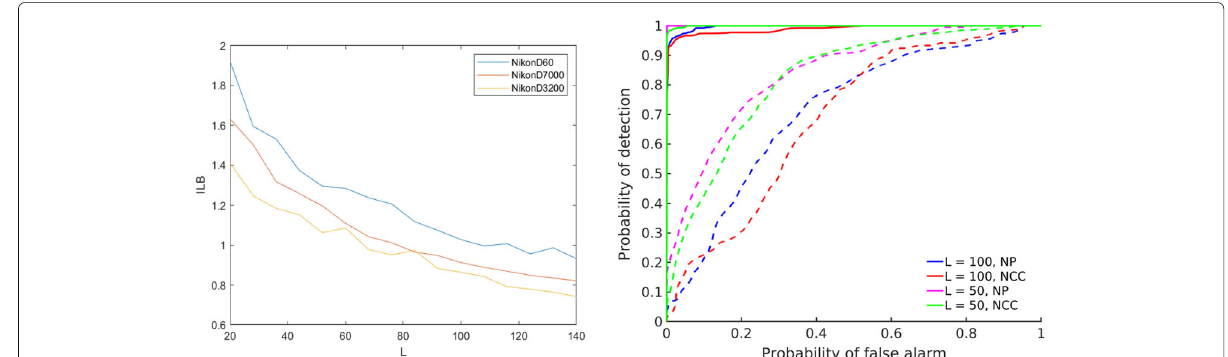
Fig. 4 (Left) Information Leakage Bound (in bpp) vs L for three different cameras in the set, showing the expected decrease of the leakage with respect to L . (Right) Receiver operating characteristic for the NP detector and the NCC, for L = 100 and L = 50. Results for the wavelet denoiser. Solid lines: Nikon D7000; dashed lines: Canon 600D. The results indicate that both the NP and the NCC detectors provide a similar detection performance for the Nikon D7000. In contrast, the results for the Canon 600D are less favourable, which is in agreement with the results for the lower bound depicted in Table 1. In both cases, the detection performance degrades significantly when L